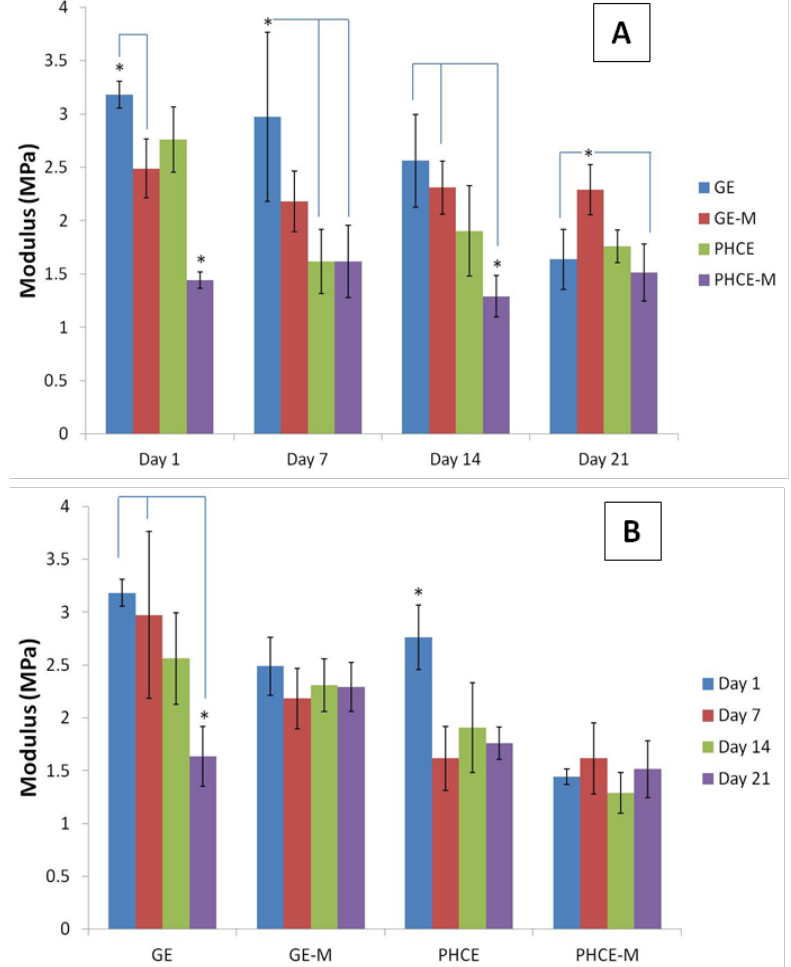
Figure 9. Young’s modulus for compression of ( A ) scaffolds at a given time point and ( B ) a given scaffold over 21 days incubation in media. Overall PHCE-M scaffolds report lower Young’s modulus values when compared to GE and GE-M